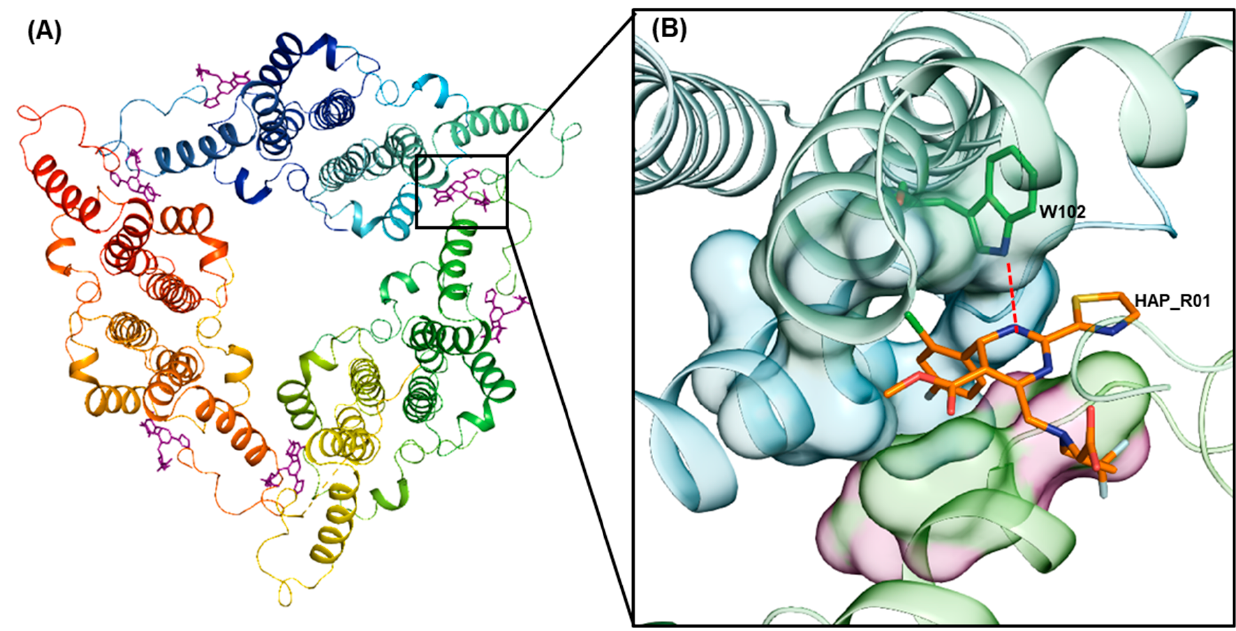
Figure 2. ( A ) Binding sites of HAP_R01 in a Cp “trimer of dimers” complex. HAP_R01 molecules are shown as purple sticks; ( B ) HAP_R01 binding pocket at B–C interface. Chain B and Chain C of the Cp Y132A structure are colored in light blue and light green, respectively. The key H-bond interaction between W102 and the dihydropyrimidine N-3 of HAP_R01 is depicted as a red dashed line. The deep halogen binding pocket created from the B chain part of the pocket (concave, blue) and the C chain part of the pocket (cap, green and pink) are shown in surface representation. The figure was created based on PDB ID: 5WRE